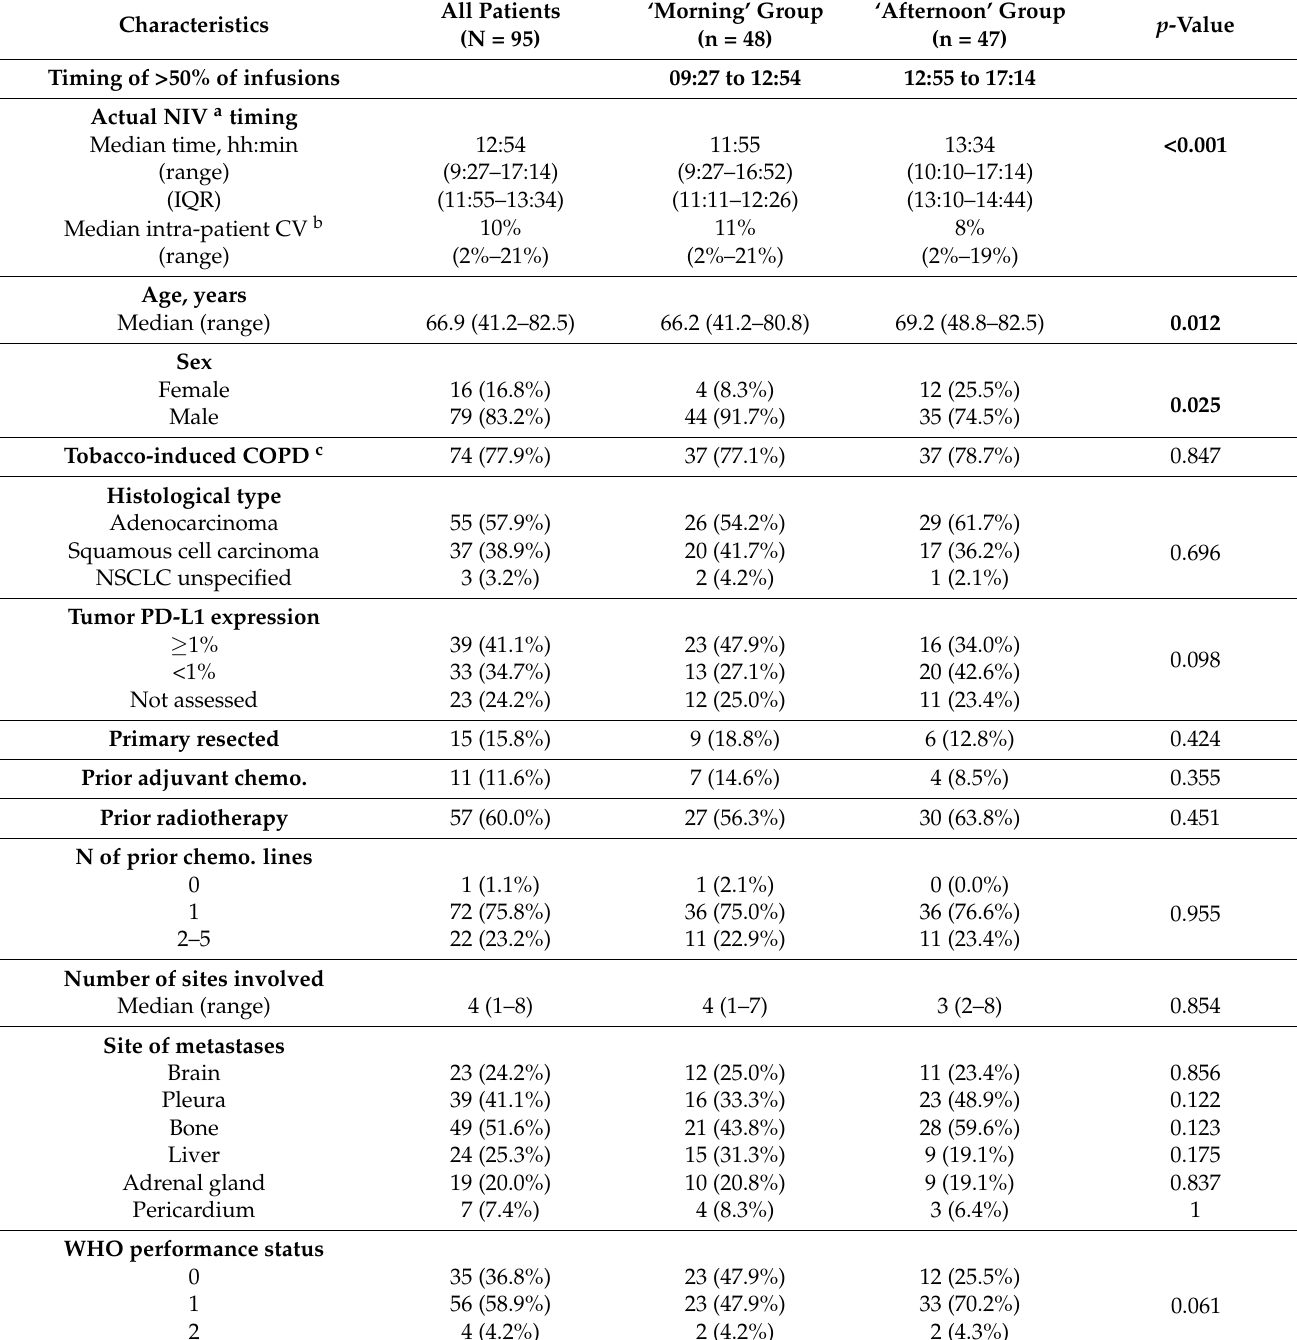
Table 1. Main baseline characteristics of whole study population, and according to nivolumab (NIV) timing